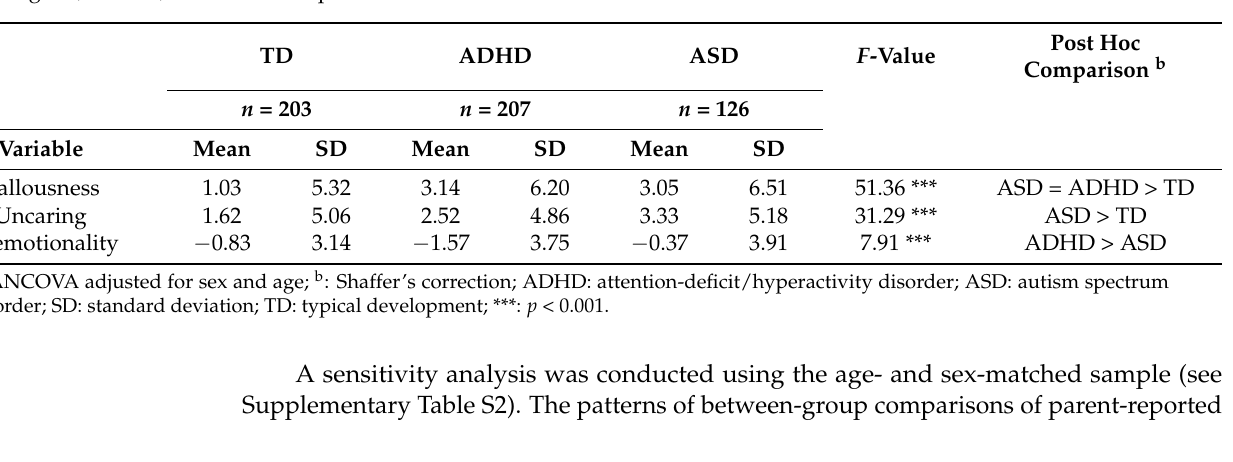
Table 4 presents the ANCOVA results for comparisons of C-ICUT subscale scores between parents and adolescents in the three groups. After controlling for the effects of sex and age, we found that the differences in adolescent-reported and parent-reported scores on C-ICUT subscales were significantly different in the TD, ADHD, and ASD groups. Post hoc comparisons revealed that the differences in callousness subscale scores in the ASD (mean = 3.05, standard deviation (SD) = 6.51) and ADHD groups (mean = 3.14, SD = 6.20) were significantly higher than those in the TD group (mean = 1.03, SD = 5.32), the difference in uncaring subscale scores in the ASD group (mean = 3.33, SD = 5.18) was significantly higher than that in the TD group (mean = 1.62, SD = 5.06), and the difference in the unemotional subscale scores in the ADHD group (mean = − 1.57, SD = 3.75) was significantly higher